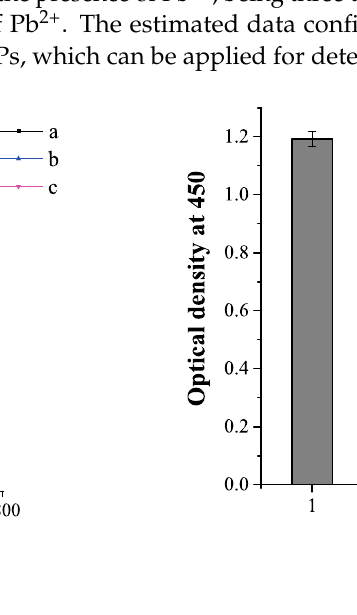
100 ng × mL − 1 Pb 2+ + 0.5 M H 2 O 2 + 0.5 mM TMB. ( N = 3). ( b ) Pb 2+ -promoted catalytic activity of TA-capped AuNPs during